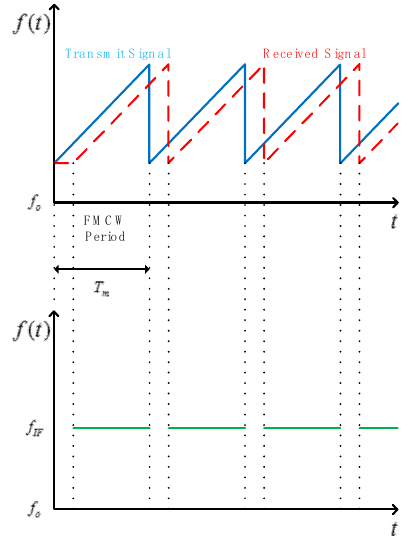
Figure 2. Linear frequency modulated continuous wave (LFMCW) signal